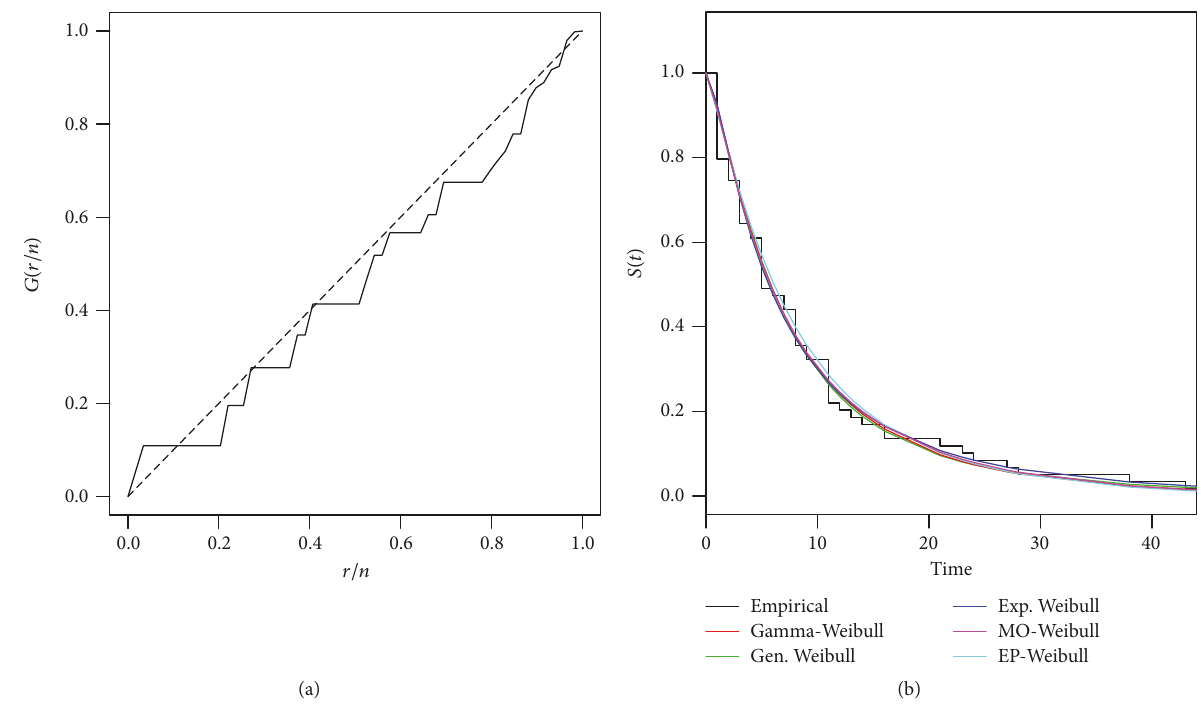
Figure 3: Pricker B empirical (a) TTT-plot, and (b) contains the fitted survival superimposed to the empirical survival function and the hazard function adjusted by distribution.